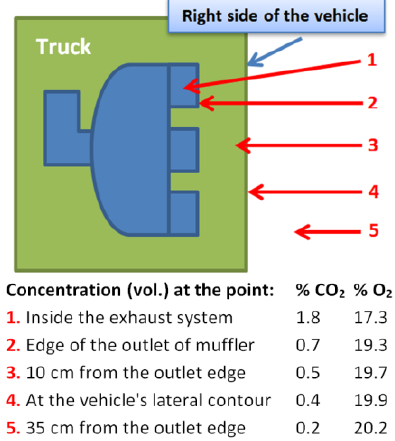
Fig. 5. Distribution of CO 2 and O 2 concentration as a function of distance from the exhaust outlet of the Mercedes Actros truck